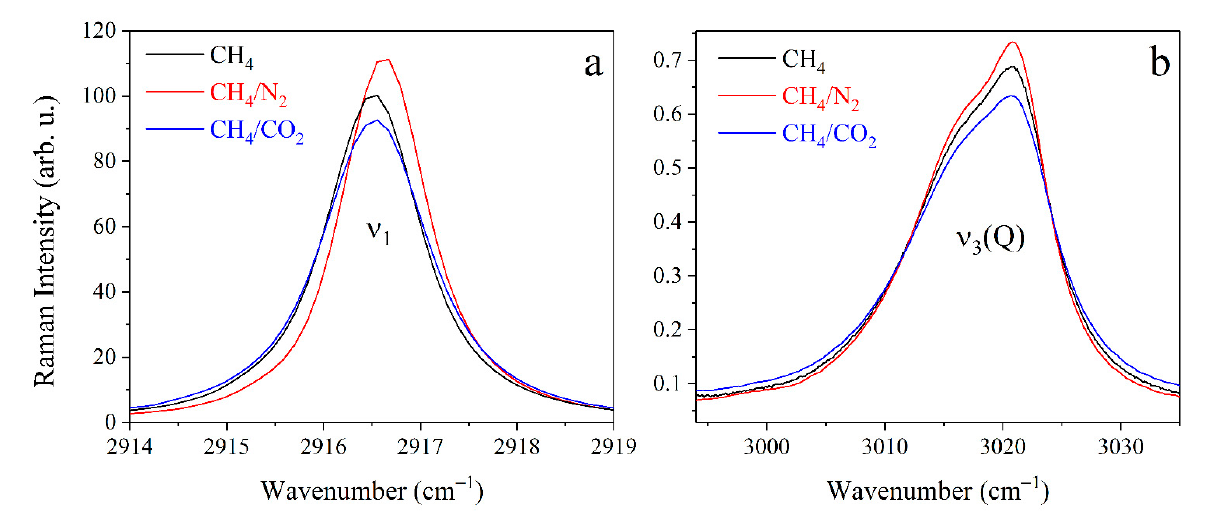
Figure 3. Experimental Raman spectra of the polarized ν 1 band ( a ) and the depolarized ν 3 band ( b ) of pure CH 4 and CH 4 /N 2 and CH 4 /CO 2 mixtures at a pressure of 5 MPa. All spectra were normalized by the integrated intensity.